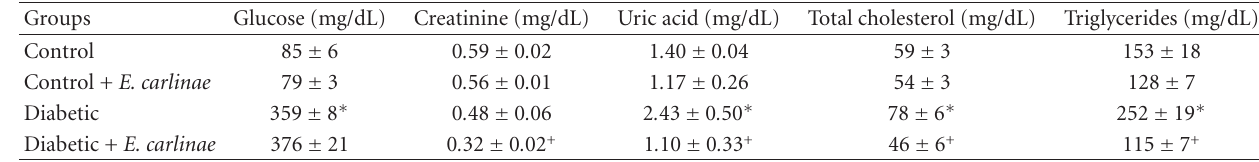
Table 3: E ff ect of E. carlinae on biochemical parameters after oral administration during 40 days. Groups Control + E. carlinae